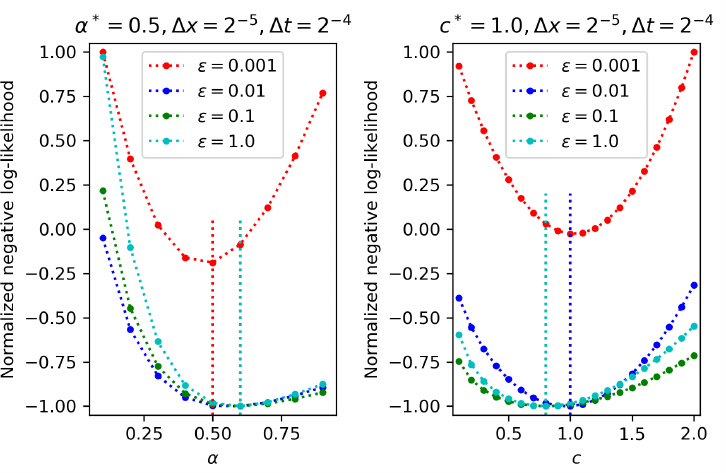
Figure 6. One-parameter estimation for a partial observation: Negative log-likelihood curves for varying α and fixed c ∗ = 1.0 ( left ) and for varying c and fixed α ∗ = 0.5 ( right ). The effect of noise magnitude on the optimal parameters is demonstrated. Curves for different noise magnitudes are displayed in different colors. The spatio-temporal steps are fixed to those of a specific partial observation with r x = 16 and r t =